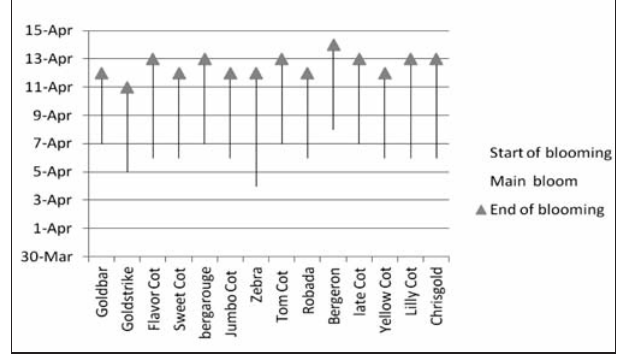
Fig 1: Time of start, main and end of blooming 14 apricot varieties through 2009 seasons.